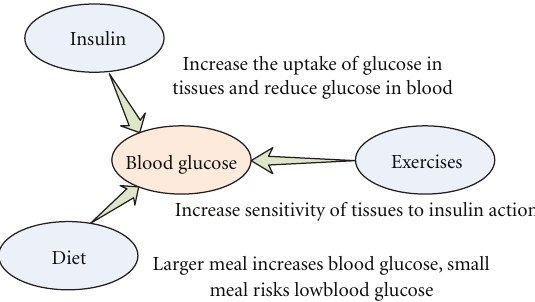
Figure 5: High-level relationship diagram of abstract groups.